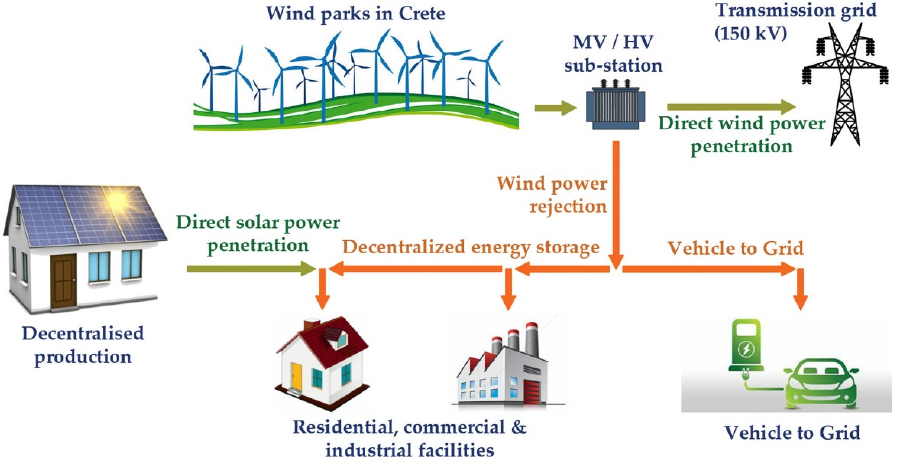
Figure 30. Indicative layout of a first approach of a smart grid approach in Crete, Greece.